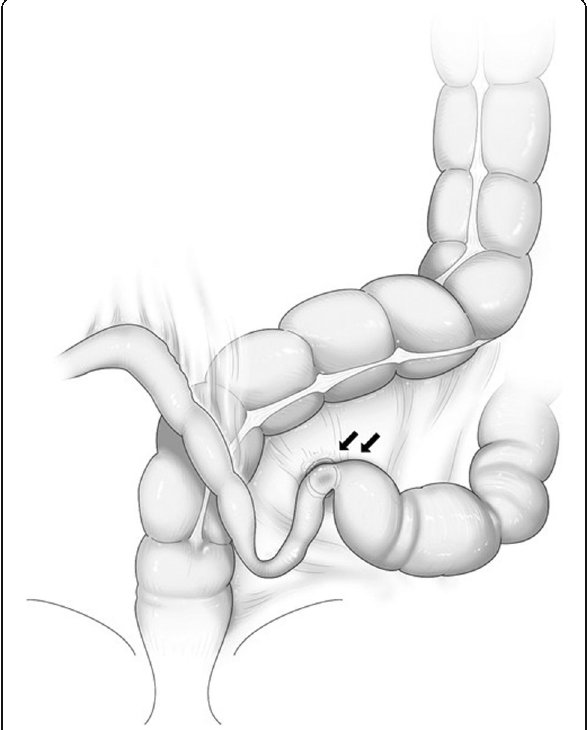
Fig. 3 Schema showing detailed findings of the intra-mesosigmoid hernia in our case (black